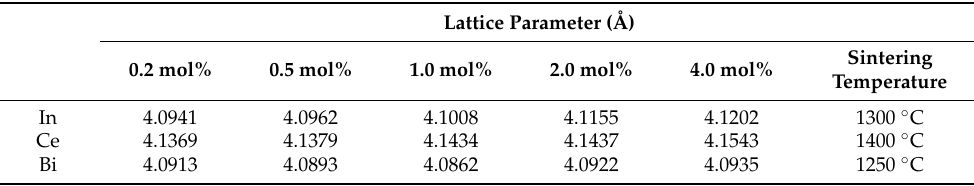
Table 4. Lattice parameters of doped BZN samples. Reprinted with permission from [48], copyright 2011,